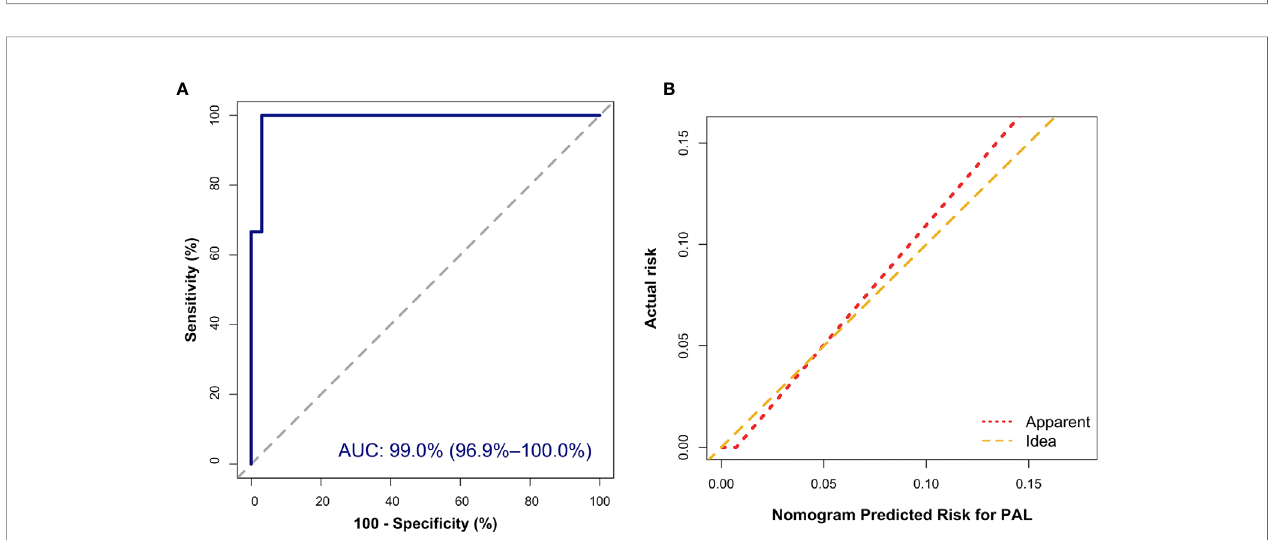
FIGURE 4 | External validation of the nomogram to diagnose PAL. (A) Discrimination: The area under the receiver operating characteristic (ROC) curve (AUC) was 99.0% (95% CI, 96.9% – 100.0%). (B) Calibration curve of the nomogram to depict agreement between predicted risks and actual outcomes of PAL. The horizontal axis represents the predicted risk of PAL, and the vertical axis represents the actual risk of the tumor. The 45° dashed line indicates perfect prediction by an ideal model, and the solid line indicates the observed (apparent) nomogram performance.